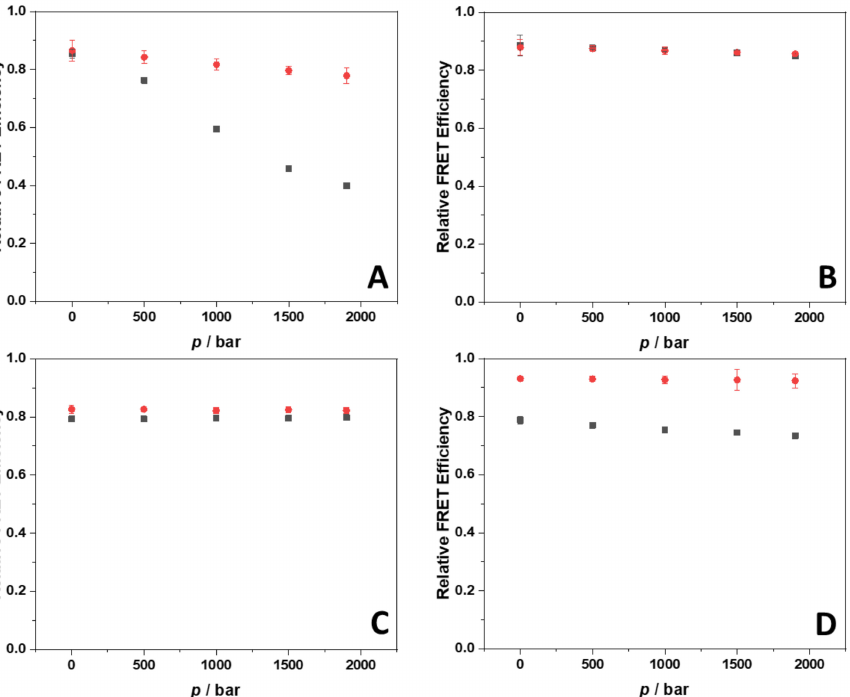
Figure 7. Relative FRET efficiency vs. pressure plots for the dually labeled 22AG (panels ( A , B )) and RG-1 (panels ( C , D )) quadruplex forming sequences in the absence (black squares) and in the presence (red circles) of berberine in 30 mM Tris buffer, pH 7.4, with the addition of 100 mM NaCl (panels ( A , C )) and 100 mM KCl (panels ( B , D )). The concentration of the labeled G4Q sequences was 2 µ M, the concentration of berberine was 200 µ M. All the experiments were performed at the temperature of 25 ◦ C. Where not visible, the error bars are smaller than the symbol